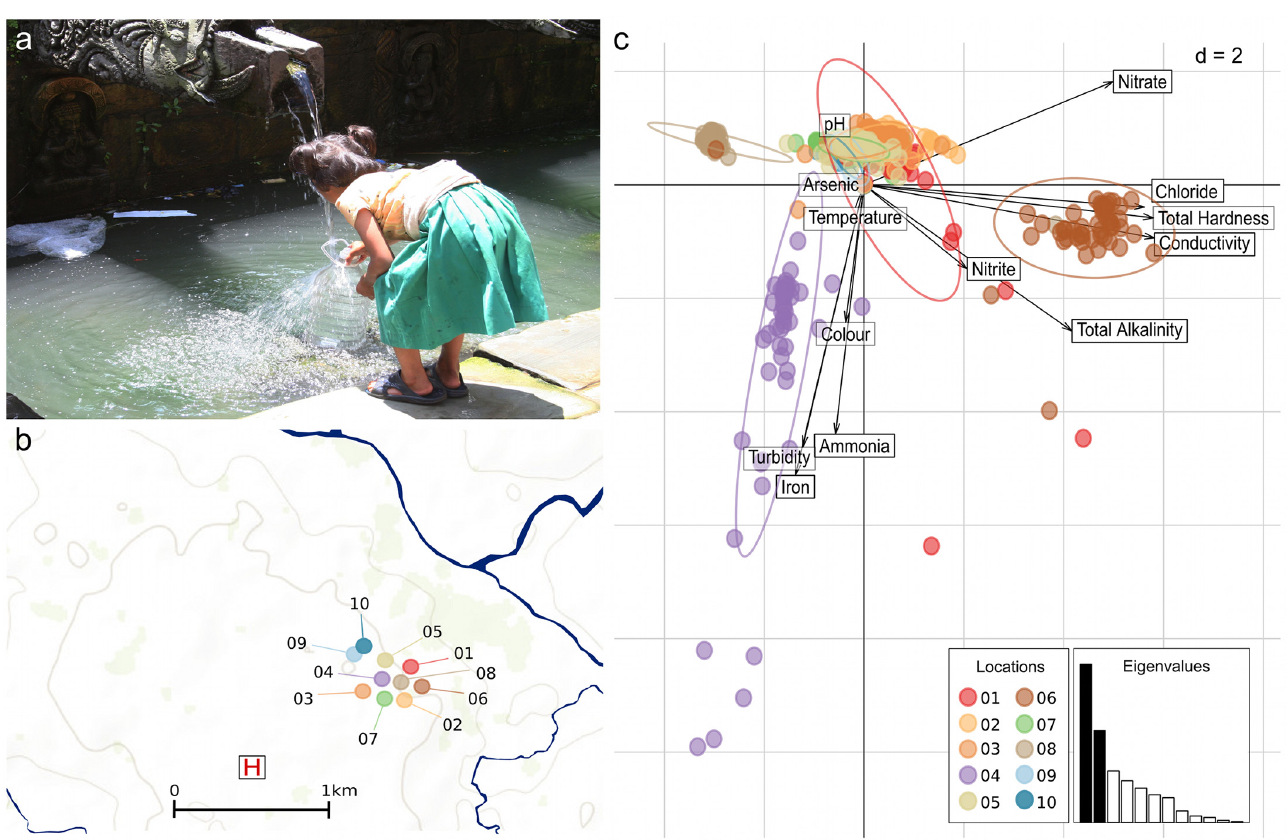
Fig 1. The physical and chemical properties of water from ten sampling locations in Kathmandu, Nepal. a) Photograph of child collecting water from a traditional stone waterspout (dhunge dhara) in Kathmandu. b) A map showing the location of the ten sampling locations in Kathmandu. The locations are color-coded corresponding to other figures and the site of Patan hospital (the healthcare facility for those with typhoid fever) is highlighted by the H symbol. (See Table 1 and Baker et al . [6] for more details regarding the sampling locations and the mapped area). c) Scaled principal components analysis of the physical and chemical properties of water samples from the ten sampled locations, showing the first two principal components (PC1-2). Individual water sample are identified by dots colored according to their sampling location (see Fig 1a). Inertia ellipses indicate the overall distribution of each water source. Labeled arrows indicate the relative contributions of the variables to the principal components, with longer arrows reflecting larger contributions. The screeplot of eigenvalues (inset) indicates the amount of variation contained in the different principal components, with PC1 and PC2 indicated in black.